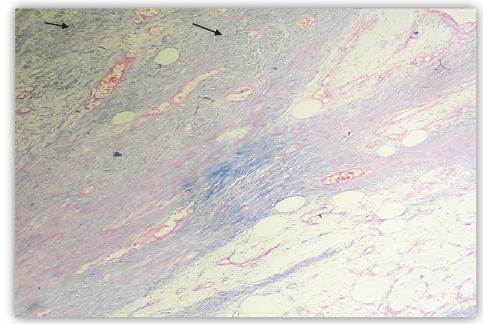
Figure 2: Fibrous Tissue in Fascicles (arrow). H & E stain (100X).